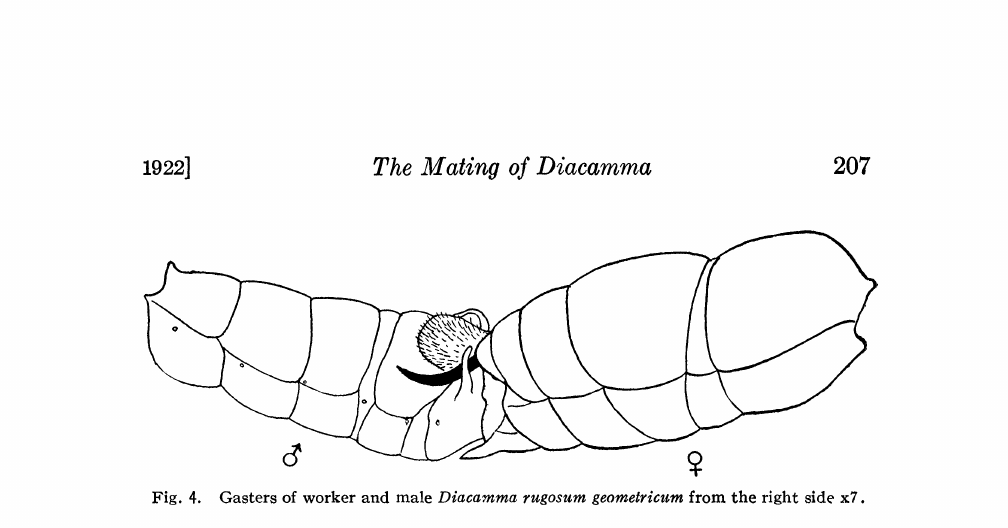
Fig. 4. Gasters of worker and male Diacamma rugosum geometricum from the right side